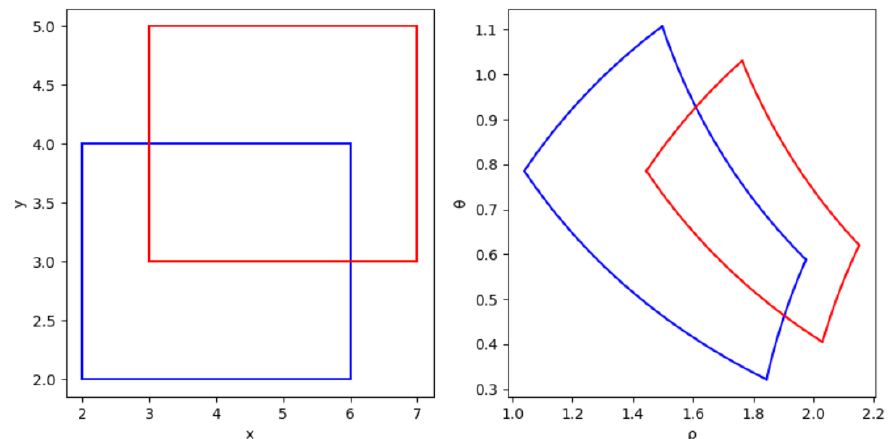
Figure 13. The ground-truth and prediction boxes are transferred from the Cartesian coordinate system ( left ) to the polar coordinate system ( right